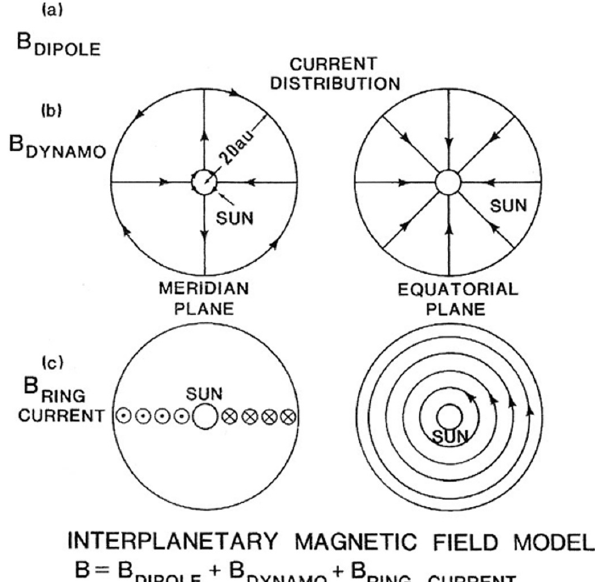
Fig. 27a. Schematic illustration of the interplanetary current